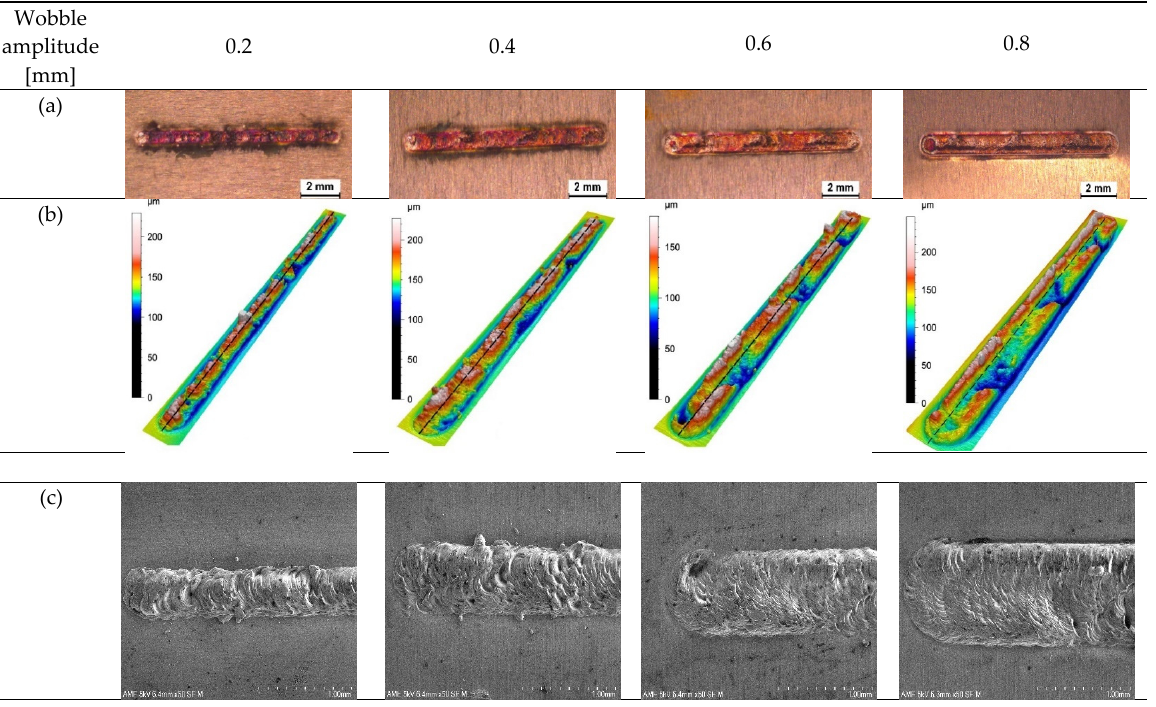
Figure 5. Top view of samples produced with different wobbling amplitudes (0.2 mm, 0.4 mm, 0.6 mm, and 0.8 mm) using ( a ) optical microscopy, ( b ) 3D surface plot, and ( c ) scanning electron microscopy (P = 750 W, PRR = 20 Hz, PW = 10 ms, F = 200 Hz, V w = 2 mm/s, and gas flow = 15 L/min).